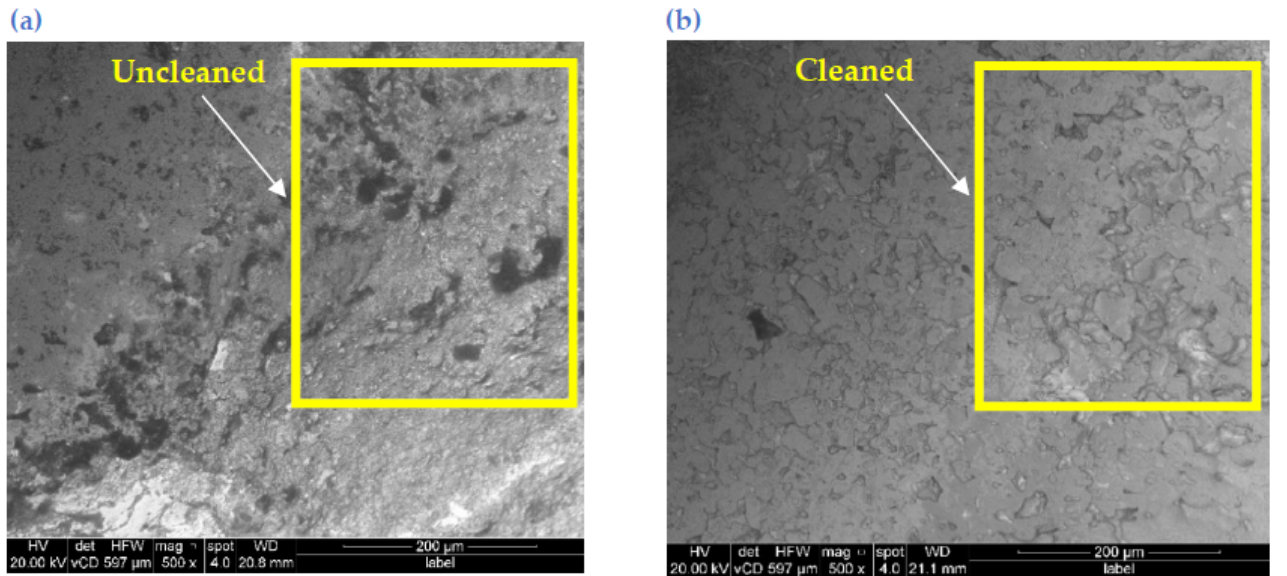
Figure 10. SEM image of sample B ( a ) before and ( b ) after cleaning at 500× magnification .